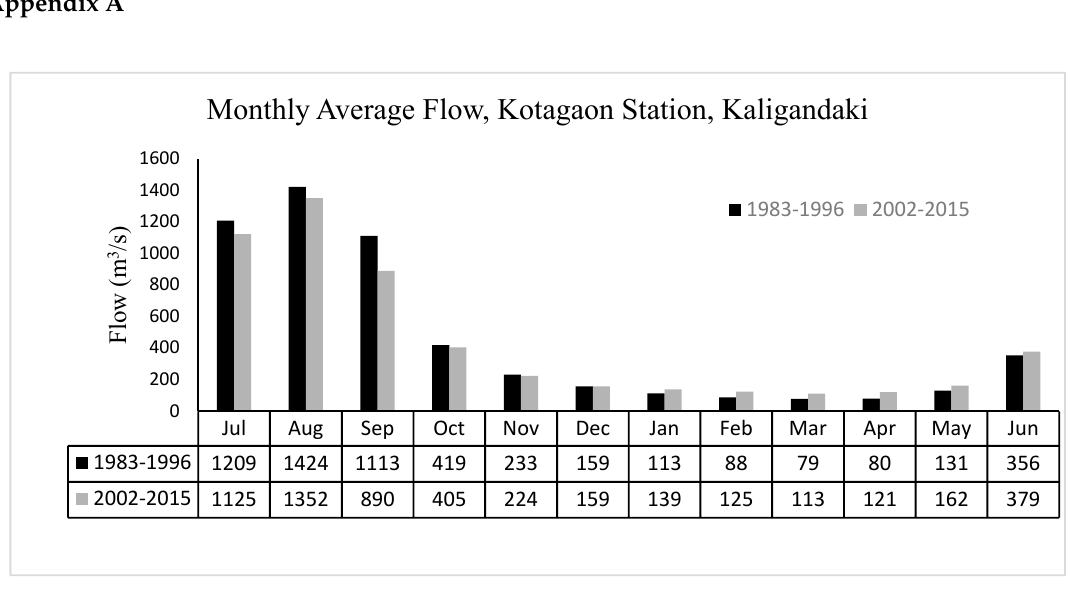
Figure A1. Monthly average flow for pre-impact and post-impact period for the Kaligandaki River.